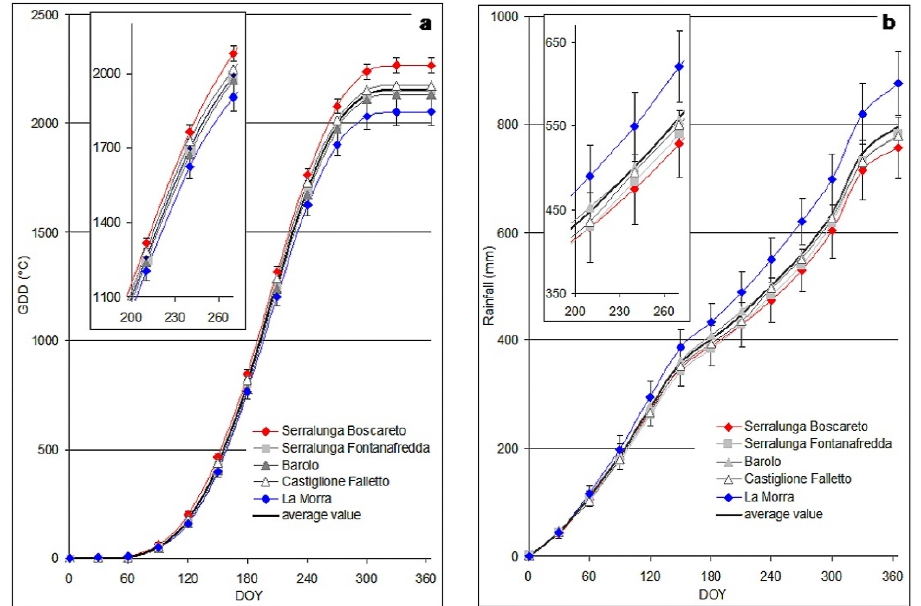
Figure 2. Yearly cumulated growing degree days (GDD, a ) and rainfall (mm, b ) calculated for the five weather stations of the area and average value for the whole area. Lines are the mean values of the 20 year-observations for Castiglione Falletto and Serralunga Fontanafredda, 19 years for La Morra, 16 years for Barolo, and 14 years for Serralunga Boscareto. In the insert, the enlarged details of the period between veraison (Julian day 210) and harvest (Julian day 275) are shown. Data of Figures 2 and 3 were recorded by Piedmont Agrometeorological Network, Agrometeorology Section of Ag-